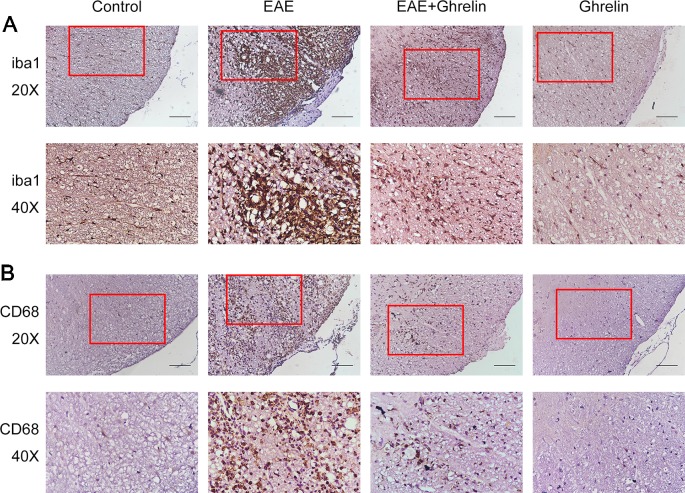
Treatment of ghrelin inhibited microglia aggregation and activation in EAE rats. IHC staining of iba1 (A) and CD68 (B) in the spinal cord tissues. Scale bars: 50 µm.